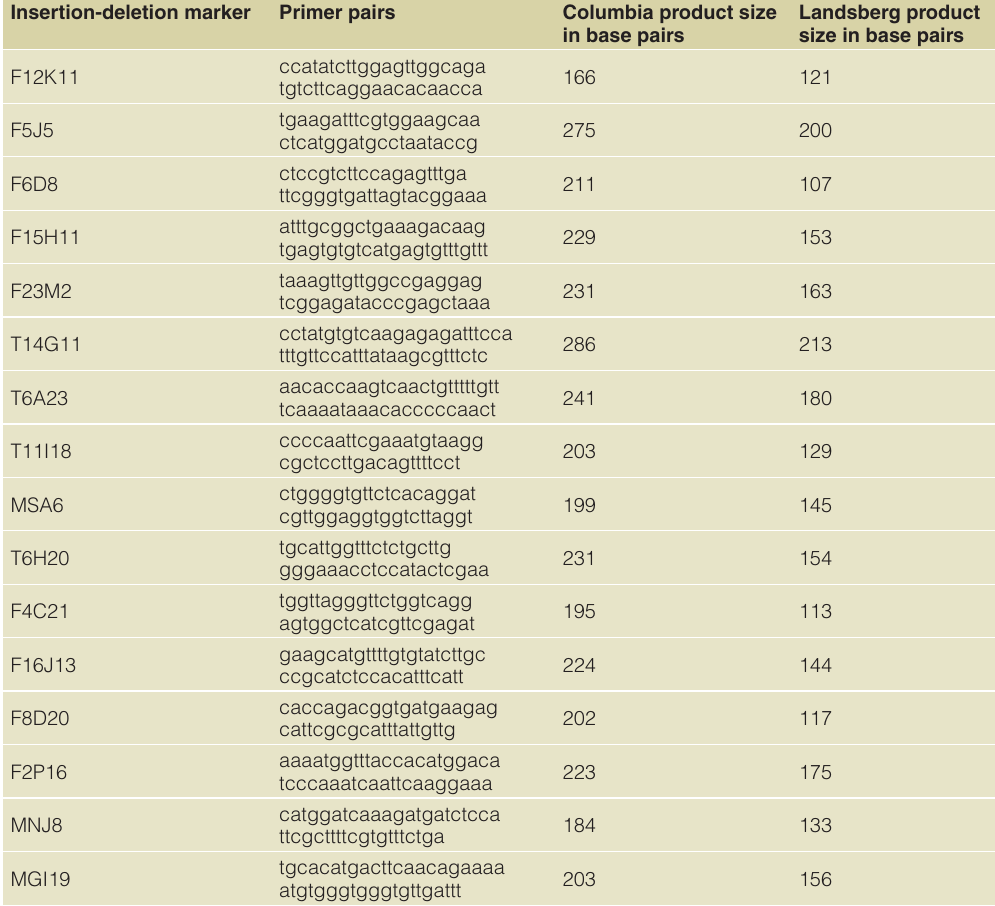
Table 1. List of primer pairs used for PCR-based molecular genotyping. Expected amplicon product sizes for the Columbia and Landsberg accessions are shown in adjacent columns. Insertion-deletion